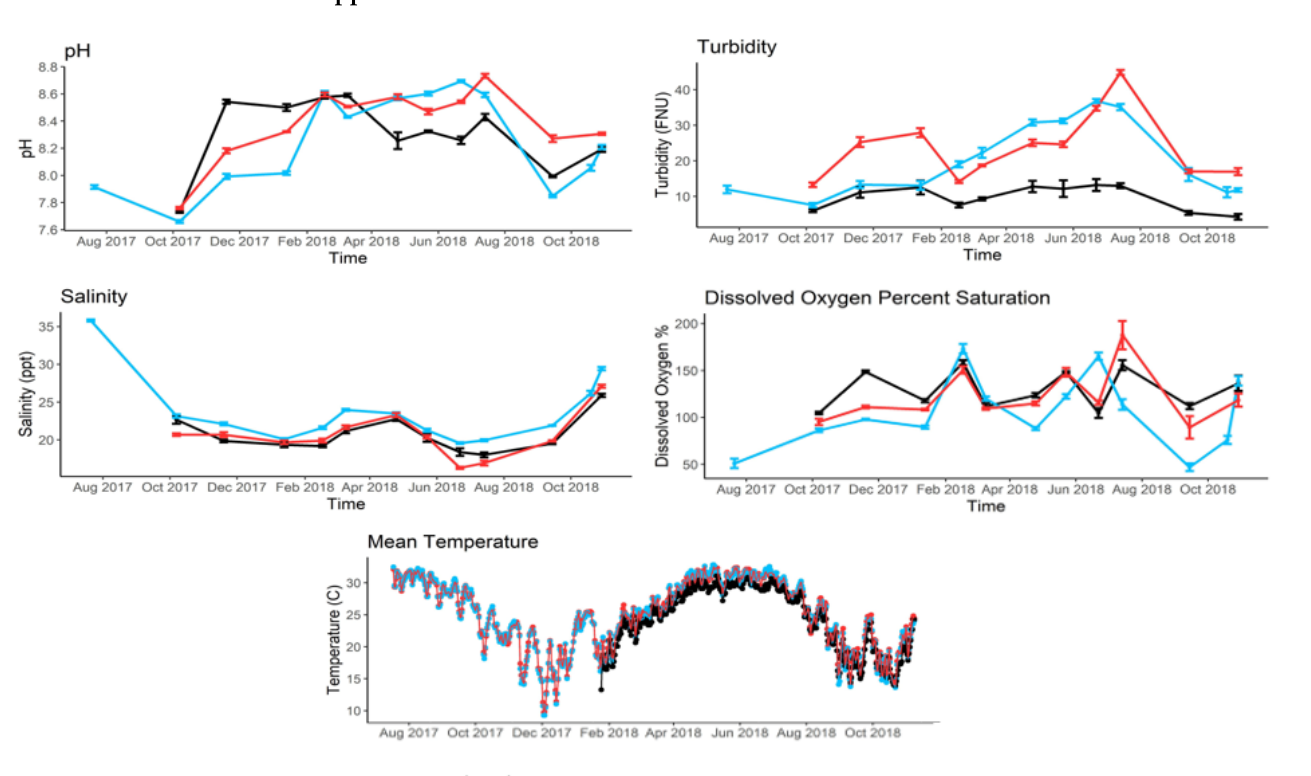
Figure A2. Mean abiotic variable values (±sd) sampled monthly throughout ITL impoundments and adjacent Banana River. Blue lines represent the northern impoundment, red line the smaller southern impoundment, and black the adjacent Banana River.